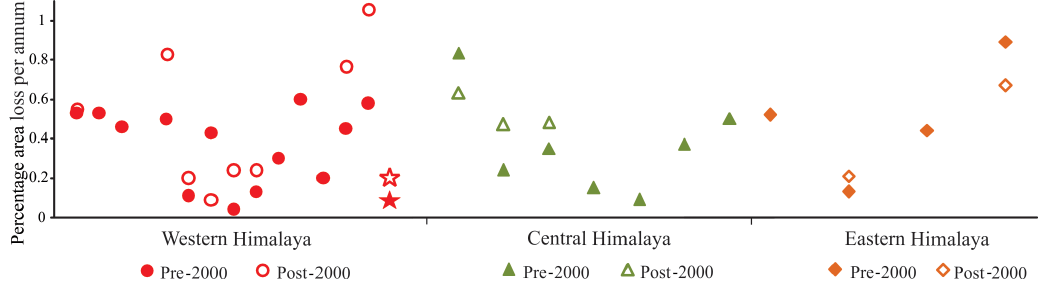
Figure 8. Annual rate of area loss of glaciers (in per cent) in three major sections of the Himalaya before and after 2000. Details of the same have been mentioned in Table S3. Results from the present study have been star-marked in the western